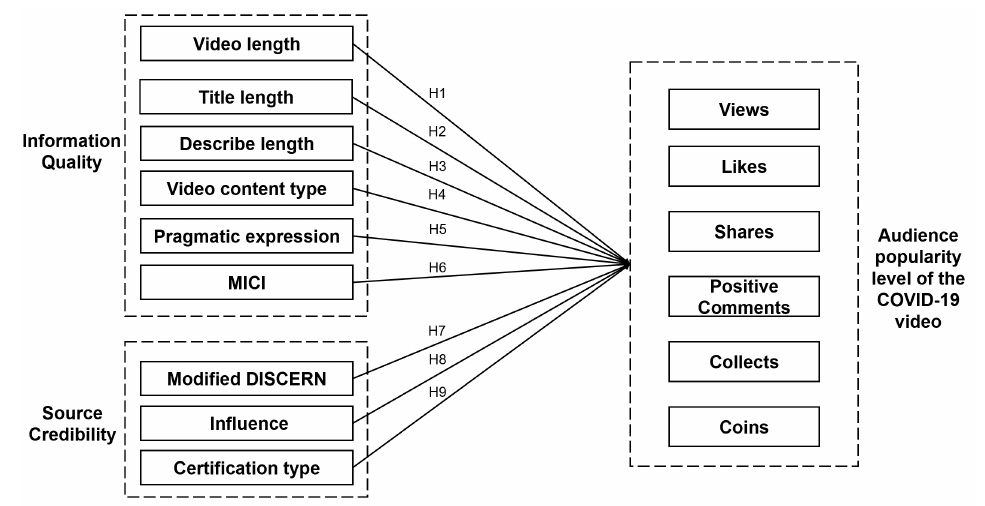
Figure 1. Research